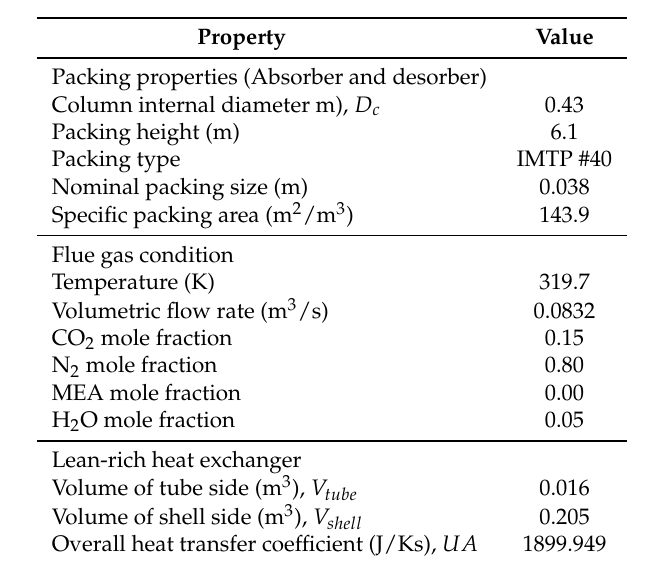
Table 1. PCC plant configuration and flue gas condition. Adapted from [20]. PCC: Post-combustion CO 2